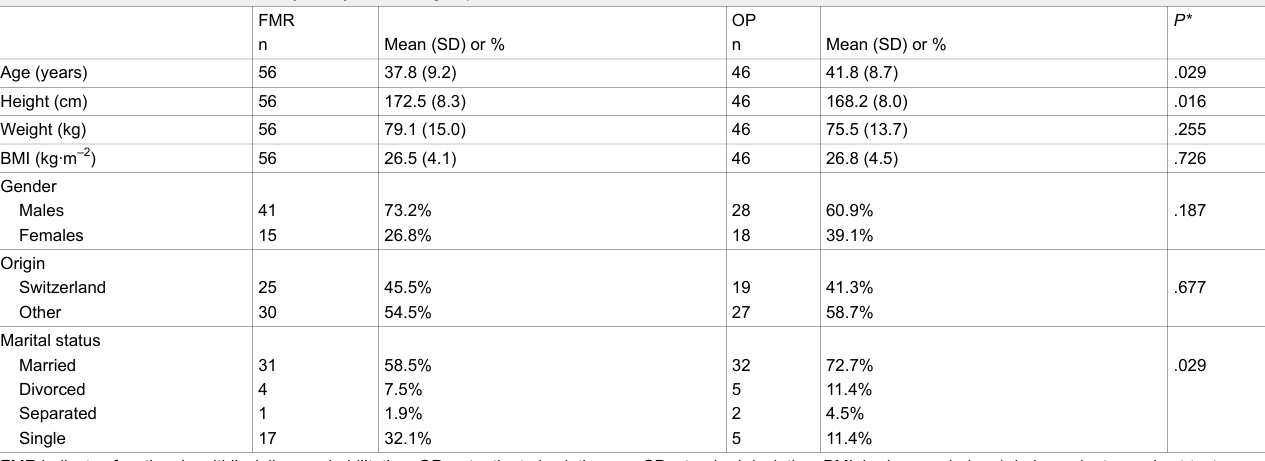
Table 1 : Baseline characteristics of subjects by treatment